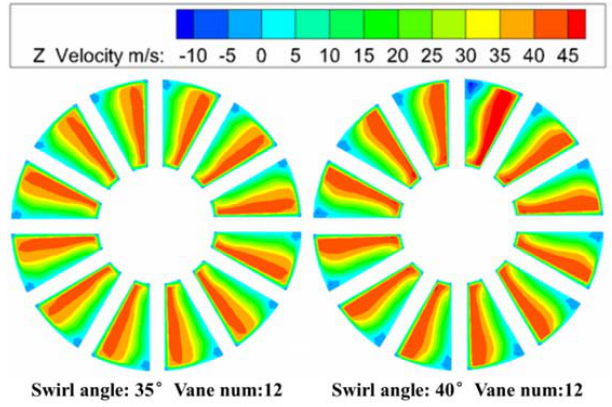
Figure 6. Comparison of airflow separation degree on suction side with different swirl angles.